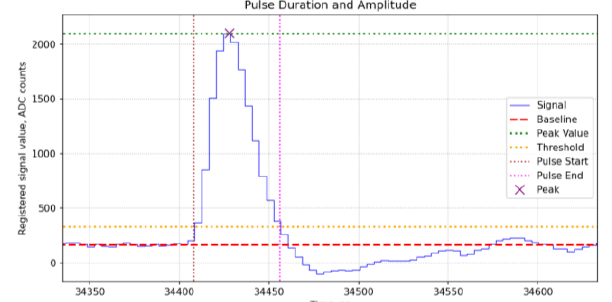
Fig. 3. The shape of the diamond detector signal pulse, as registered by a 250 MS/s ADC, and its parameters.